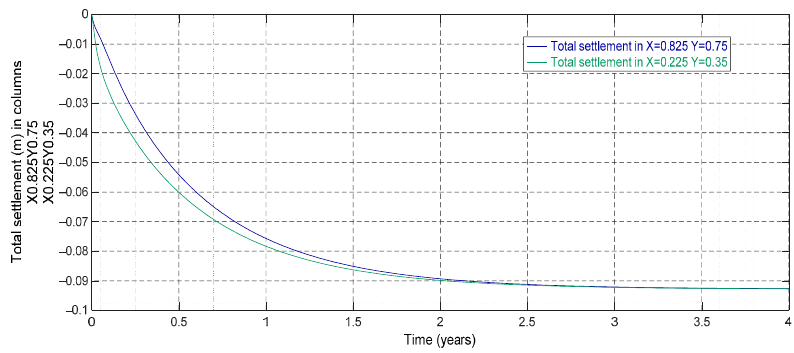
Figure 13. Evolution of the local settlement in each of the cells of a soil column (N z = 20).